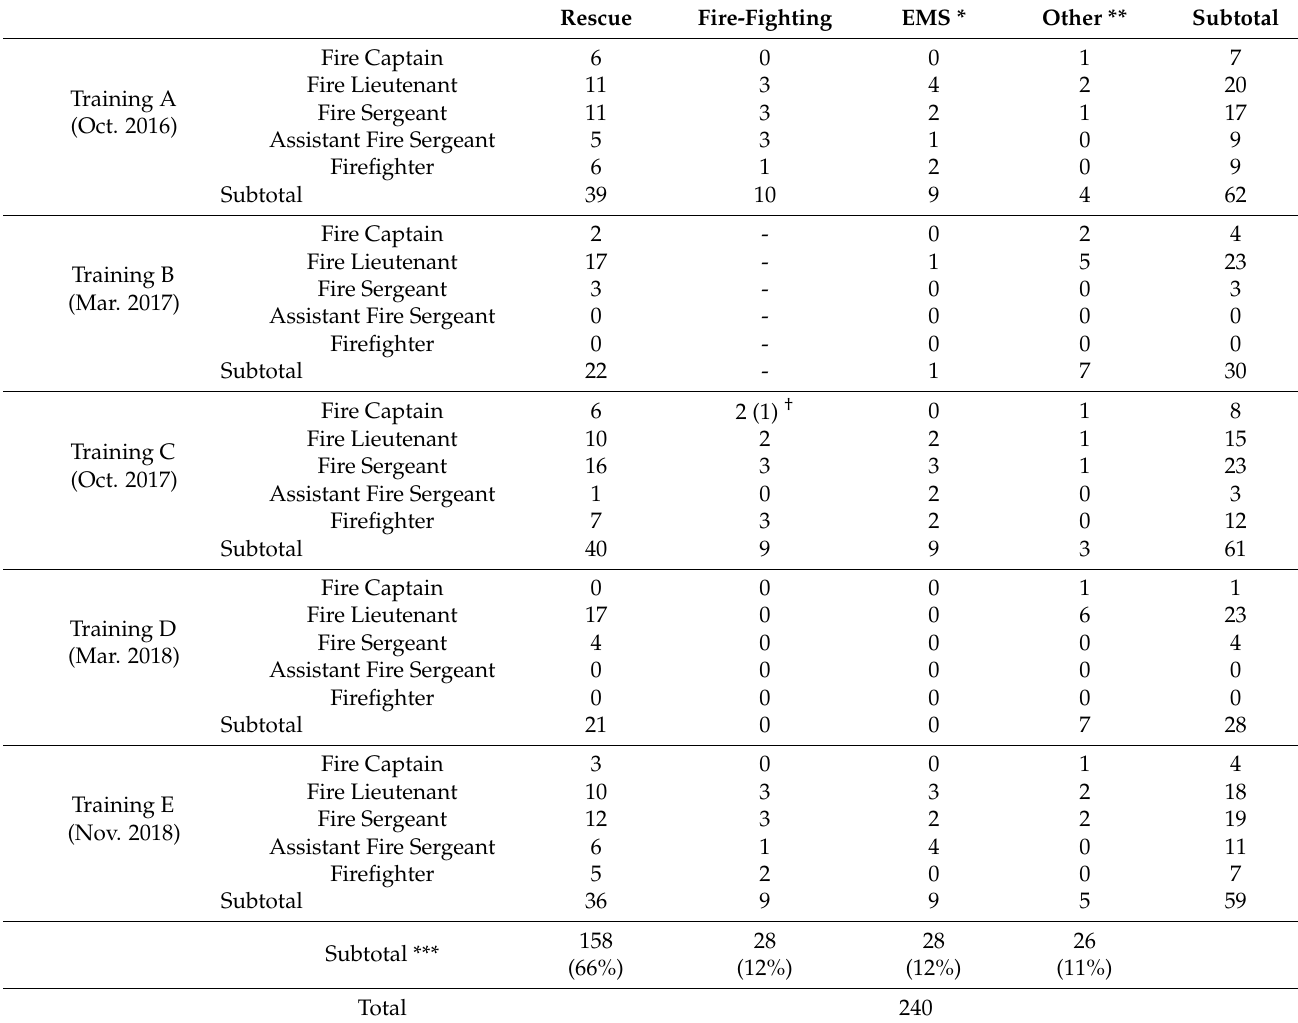
Table 1. Activity group and job rank of participants by each disaster simulation